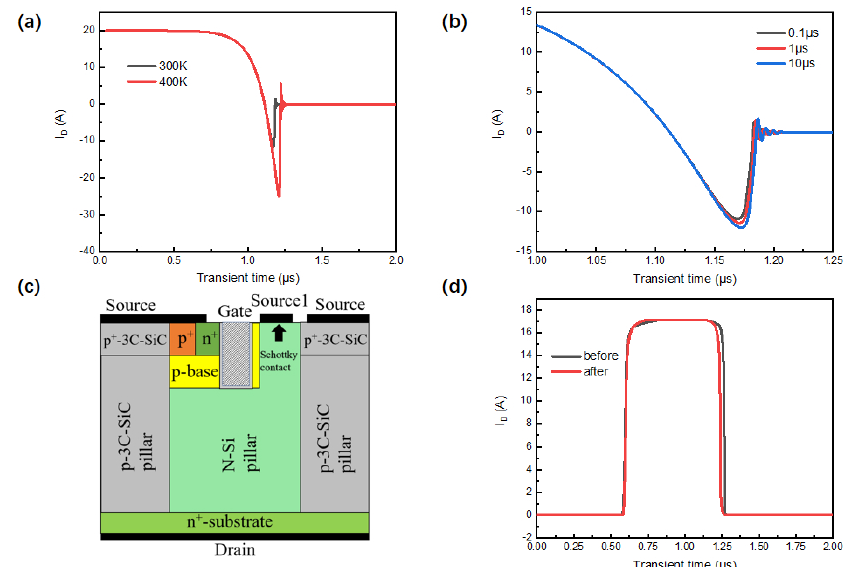
Figure 5. ( a ) Reverse recovery current with different working temperatures (300 and 400 K). ( b ) Re- verse recovery is current with different minority carrier lifetimes. ( c ) A newly designed Si/SiC SJ structure with SBD to improve switching characteristics. ( d ) Switch waveforms of body diodes of new construction, compared to the Si/SiC